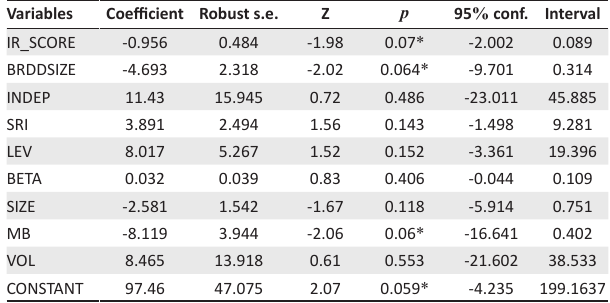
TABLE 7: Regression results: Analysts’ forecast error.